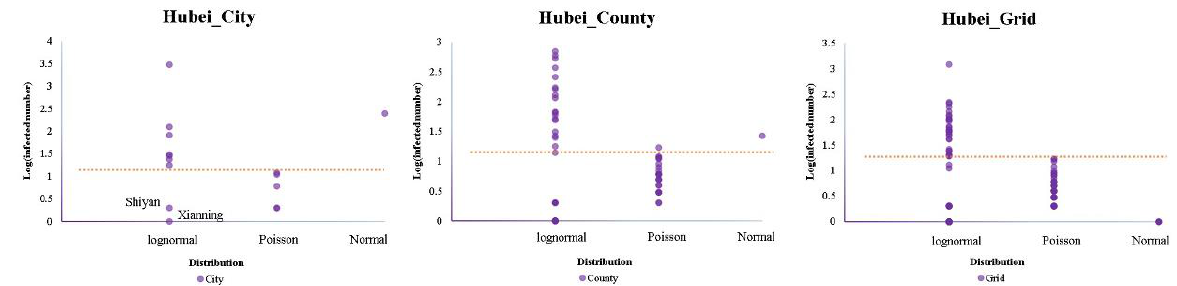
Figure 5. Scatter diagram of the number and distribution of medical infections.